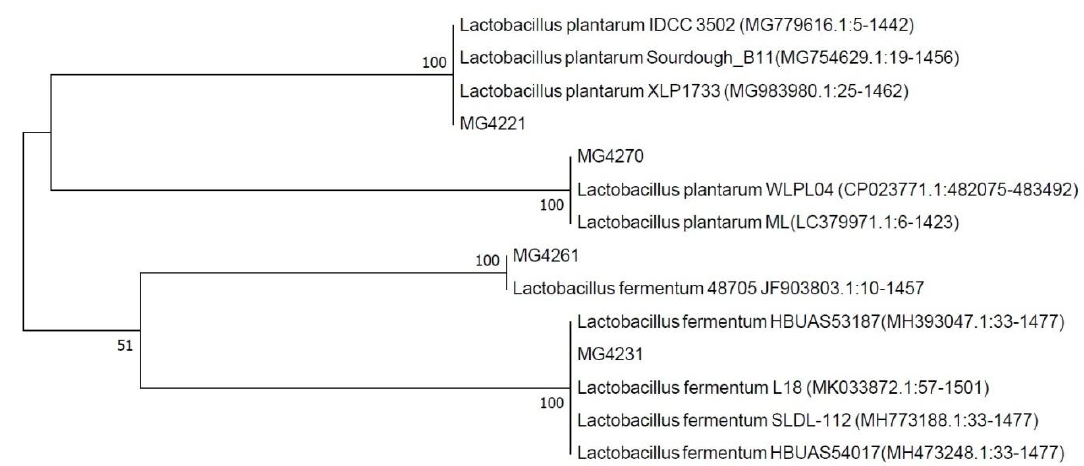
Figure 2. Neighbor-joining tree based on bacterial 16S rRNA gene sequence data, from di ff erent isolates obtained in the current study as well as sequences available in the GenBank database. Numerical values indicate bootstrap percentages from 1000 replicates.